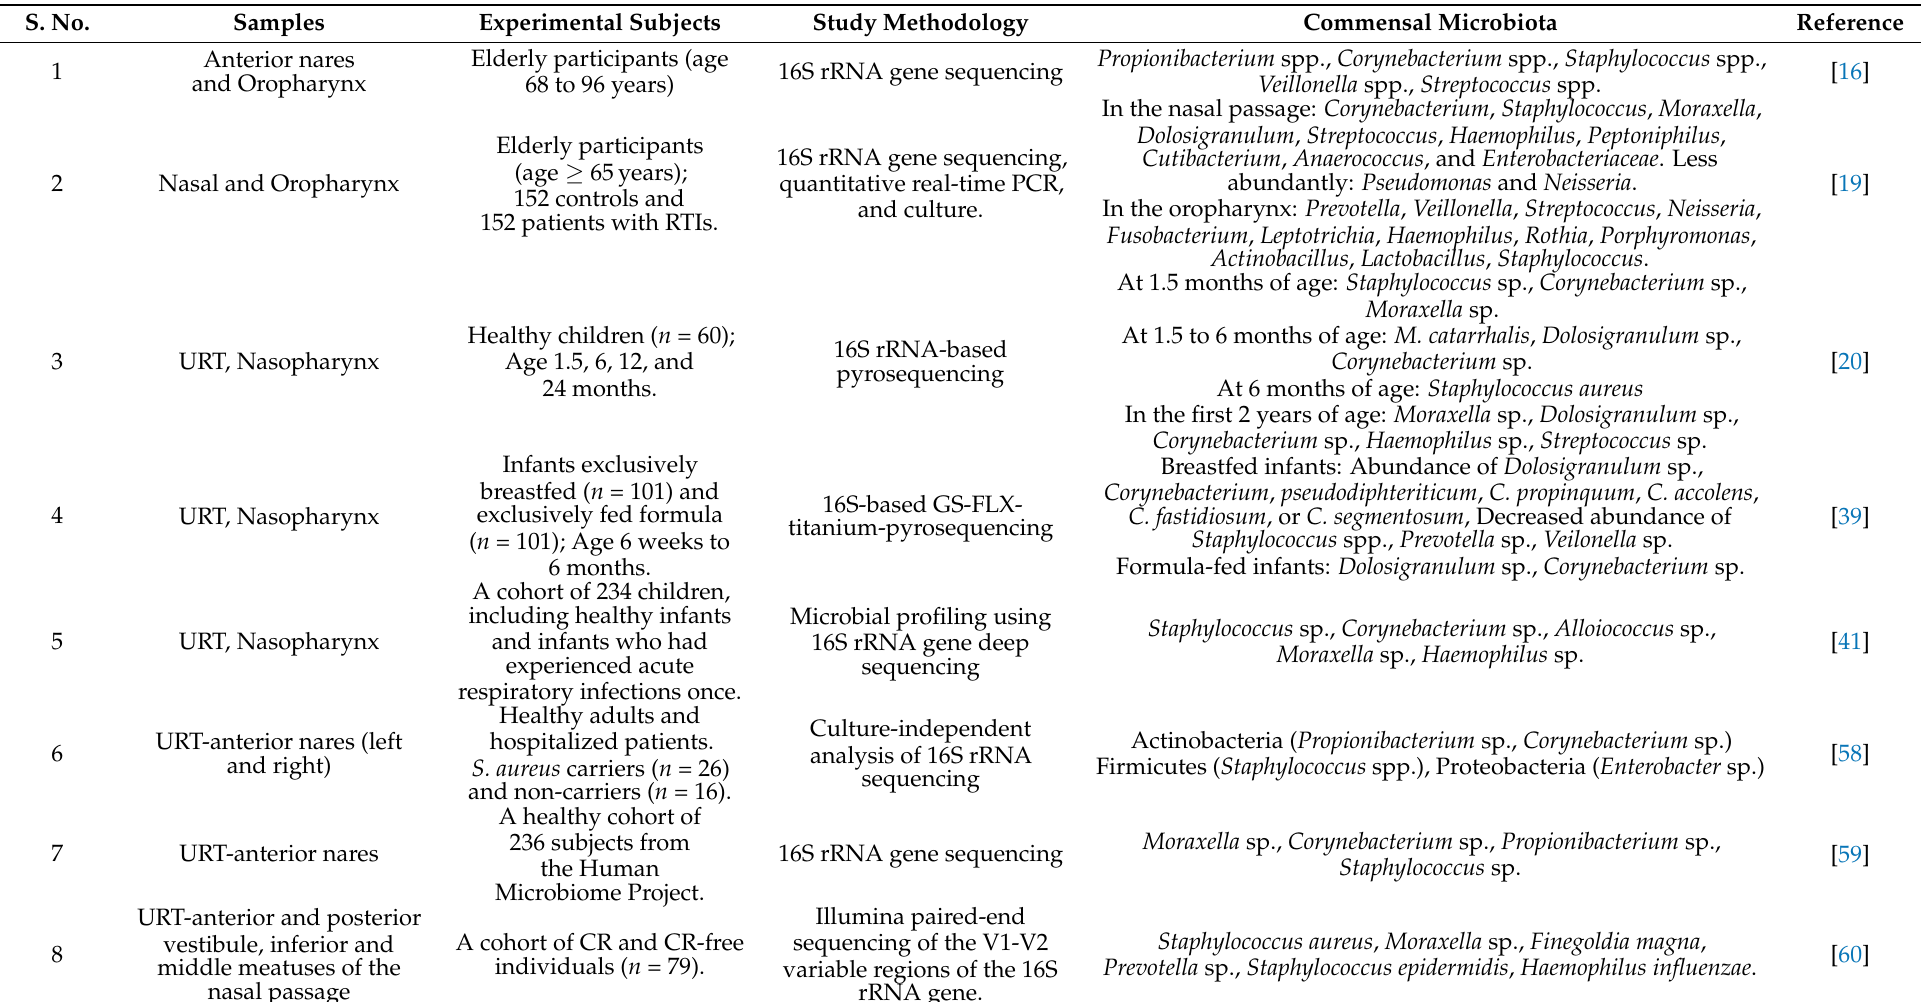
Table 1. Representing different microbial communities residing in the respiratory tract across the ages. S.